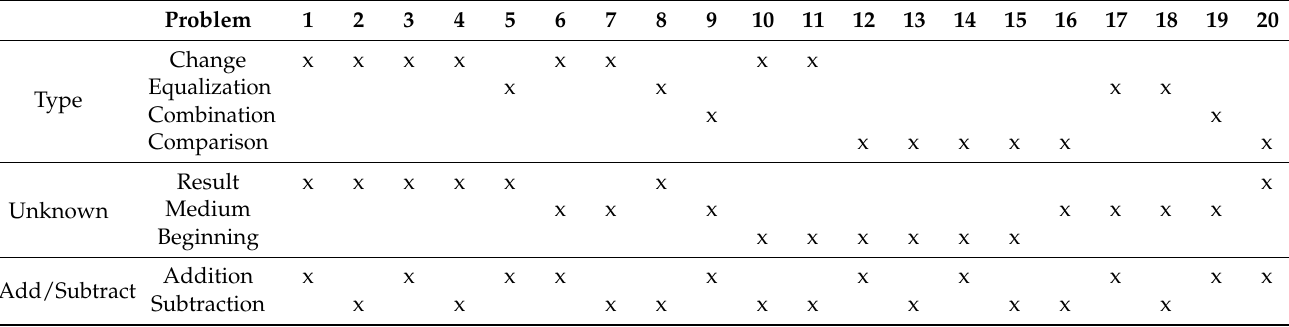
Table 5. Summary of the groupings according to the type of problem.